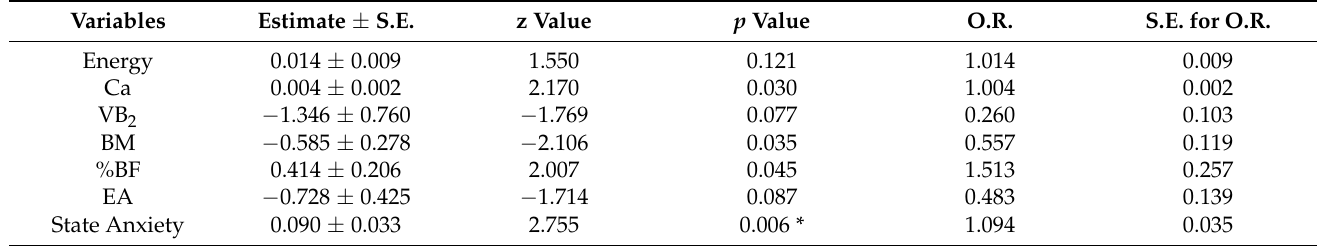
Table 4. Variables and estimates of each variable of the multiple logistic